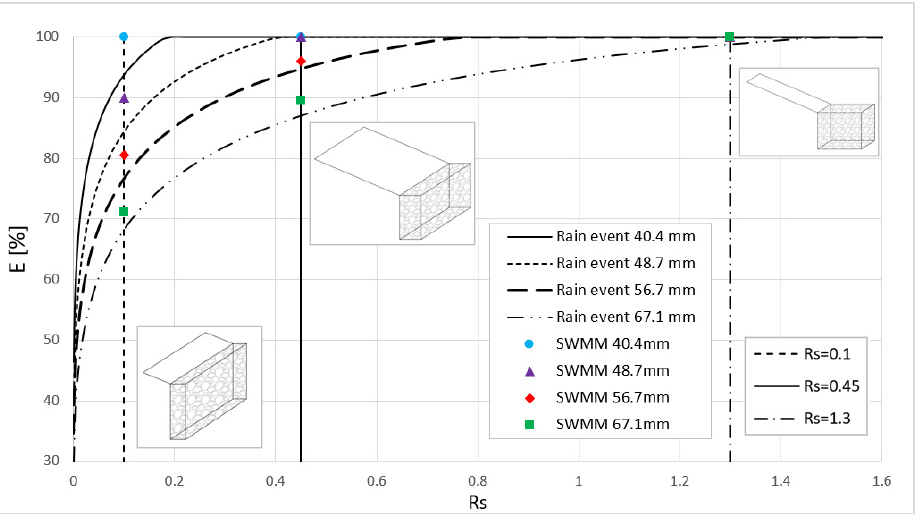
Figure 5. Efficiency as a function of shape of IS and frequency of rain event. Rainfall duration is kept constant at τ (cid:3404) 30 min . Symbols represent efficiency evaluated with the LID module of SWMM.